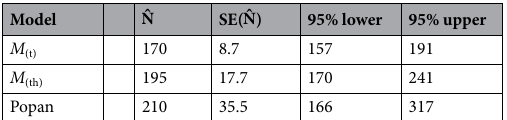
Table 3. Comparison of the estimated population size ( ˆ N ), standard error (SE) of the estimate and 95% confidence limits for closed and open models using the graded photo-identification mark-recapture data to estimate the size of the community of marked, trawler-associated dolphins over the two fishing trips (12 samples) on one trawler in the Pilbara Trawl Fishery in April 2011; The three best-fitting population models were: M (t) = allowing for variation in capture probability with time; M (th) = allowing for both time and individual heterogeneity in capture probability; and Popan = an open population model, assuming closure within sampling